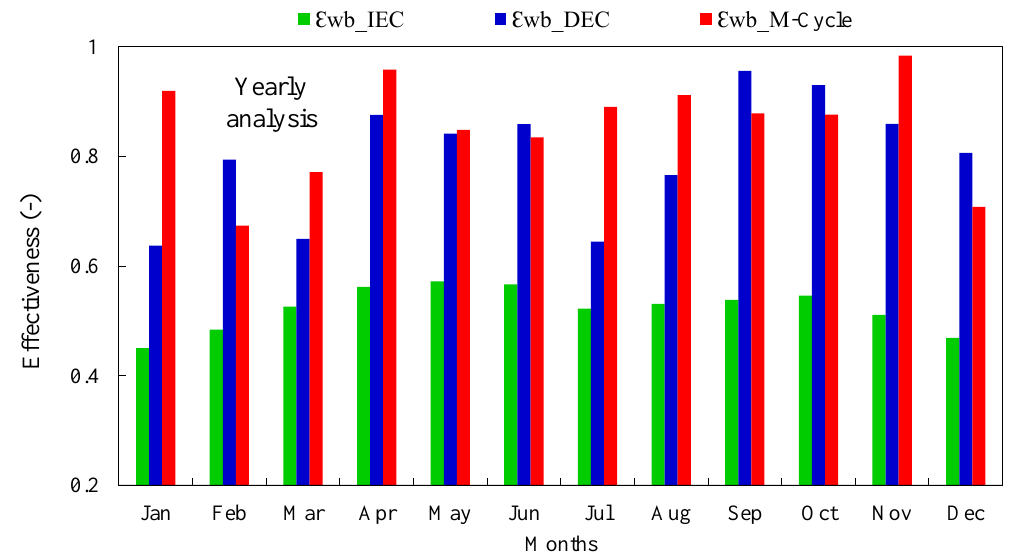
Figure 7. The achieved wet-bulb effectiveness of the EC systems against the results presented in Figure 6 for climatic conditions of Multan.